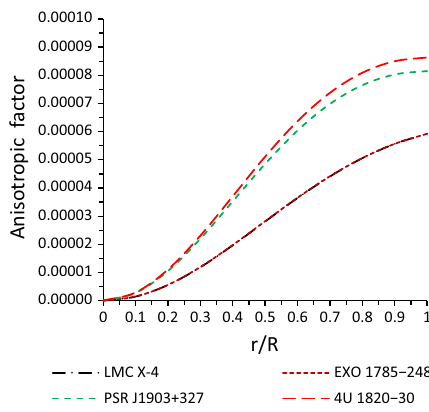
Fig. 4 Behaviour of pressure–density ratio p i /ρ vs. fractional radius r / R for LMC X-4, EXO 1785-248, PSR J1903+327 and 4U 1820-30. For plotting this figure the numerical values of physical parameters and constants are as follows: (i) a = 0 . 004, b = 0 . 0021, c = 0 . 0107, A = 0 . 4806, B = 1 . 2607, M = 1 . 29 M (cid:7) , and R = 8 . 831 km for LMC X-4, (ii) a = 0 . 00393, b = 0 . 0025, c = 0 . 01074, A = 0 . 4905, B = 1 . 2293, M = 1 . 3 M (cid:7) and R = 8 . 849 km for EXO 1785-248, (iii) a = 0 . 005, b = 0 . 0004, c = 0 . 01481, A = 0 . 4654, B = 1 . 0551, M = 1 . 667 M (cid:7) and R = 9 . 438 km for PSR J1903+327, (iv) a = 0 . 0055, b = 0 . 0002, c = 0 . 0155, A = 0 . 44506, B = 1 . 1286, M = 1 . 58 M (cid:7) and R = 9 . 1 km for 4U